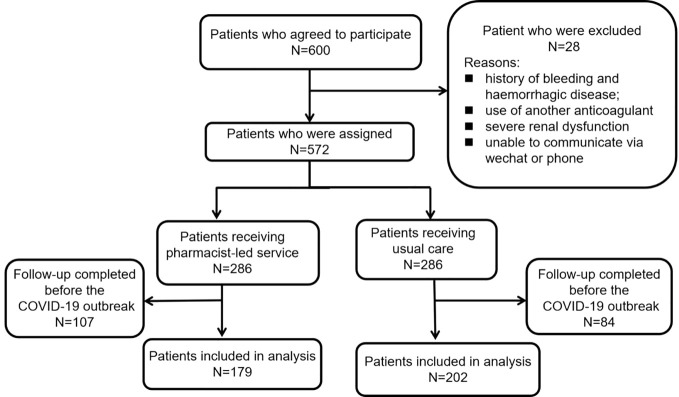
Flowchart recruitment procedure of the study.